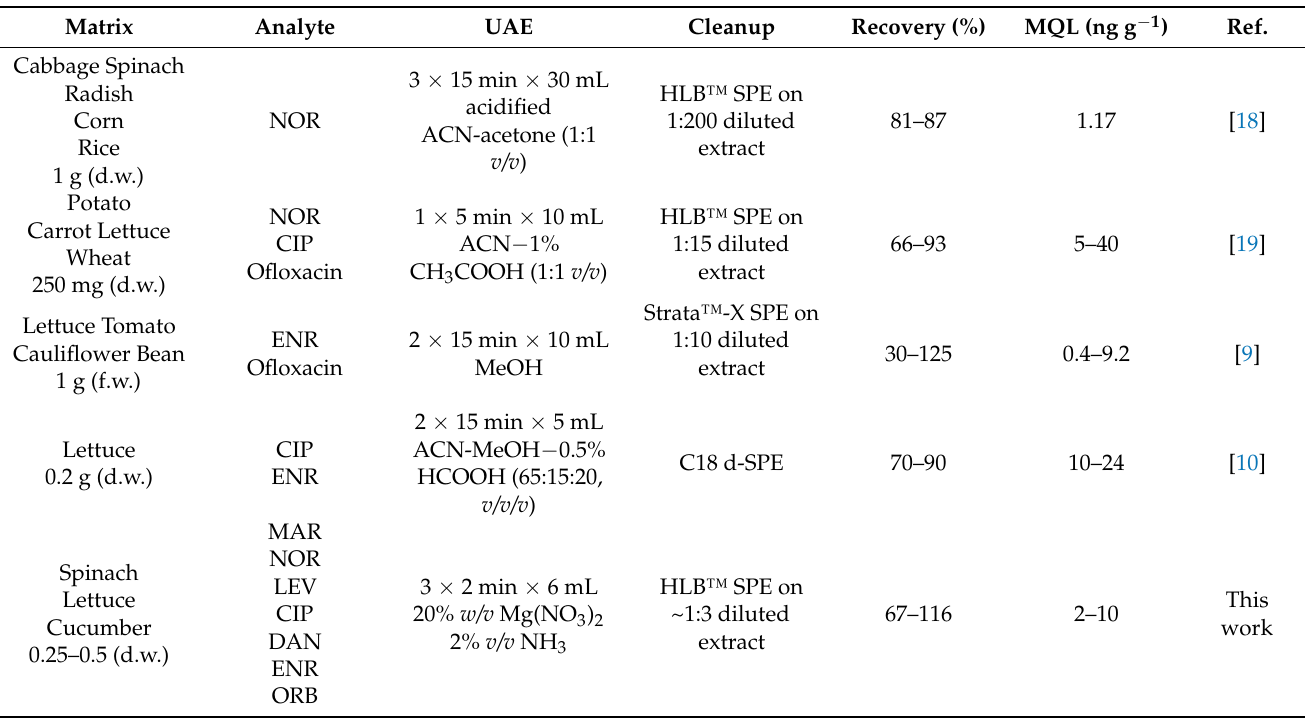
Table 3. Comparison with current methods entailing UAE followed by LC-MS quantification of trace FQs in